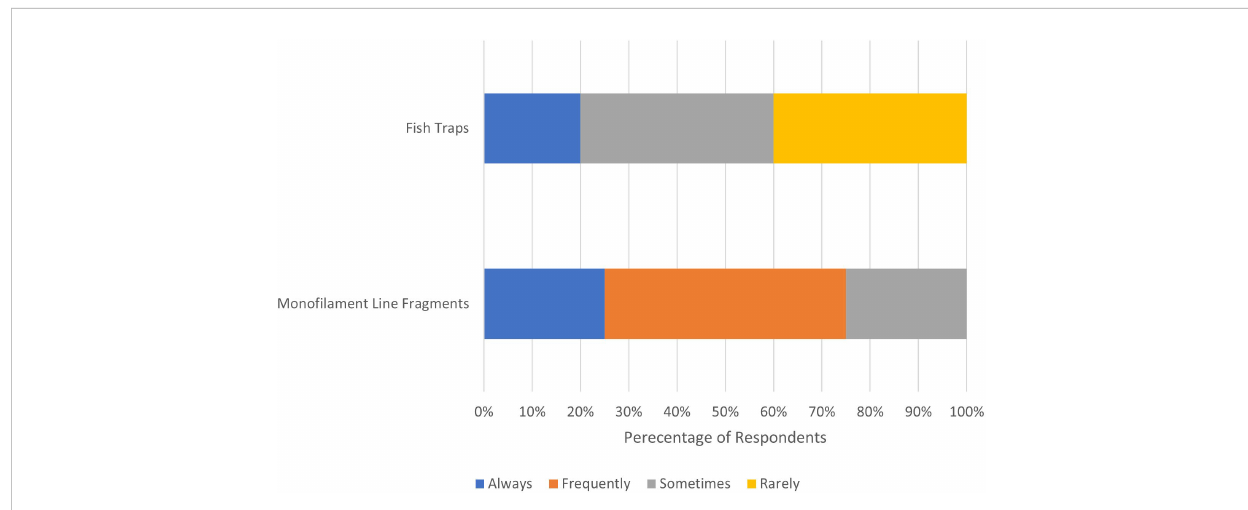
FIGURE 13 Encounter rates of derelict traps and mono fi lament nets by divers in Dominica (n = 5).